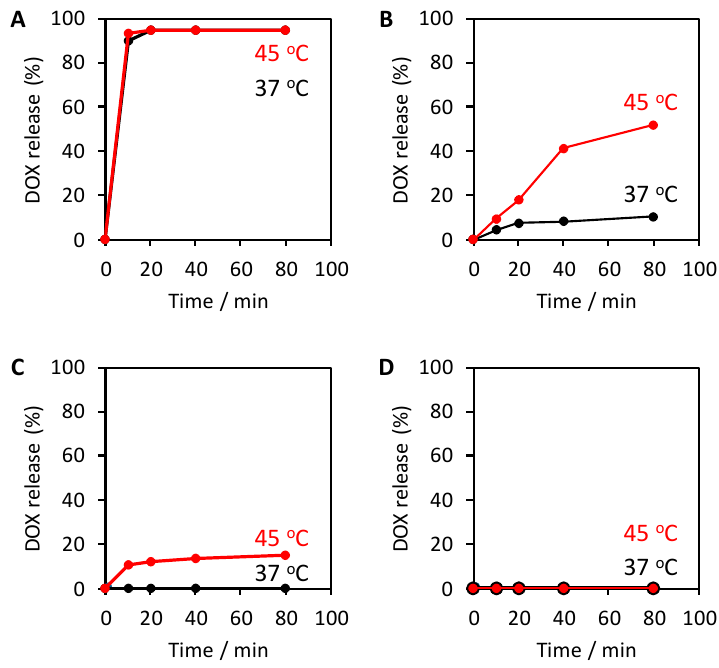
Figure 3. DOX release from the MDC sponge without crosslinking treatment ( A ) and with 1.5 h ( B ), 6 h ( C ), and 24 h ( D ) crosslinking treatment in phosphate-buffered saline (PBS) and the absence of alternating magnetic field (AMF) at 37 °C and 45 °C.